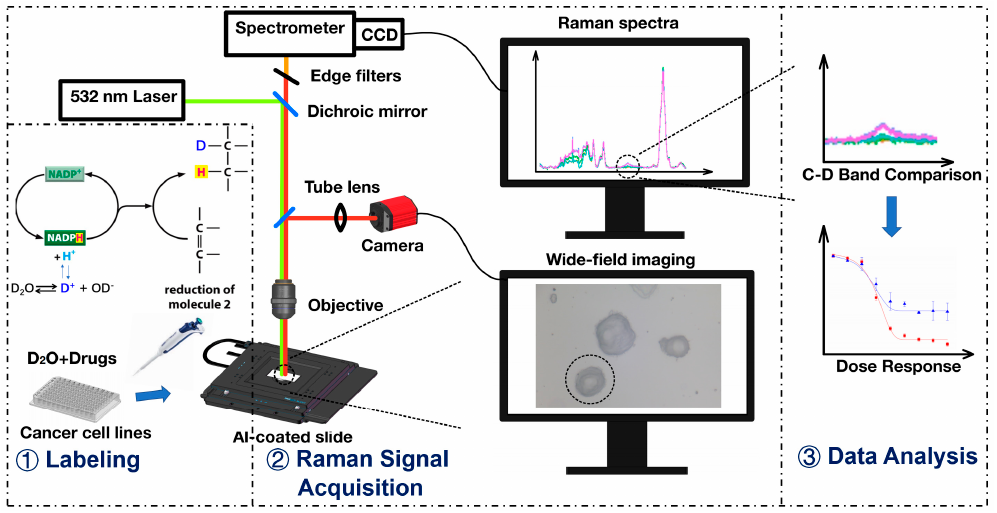
Figure 1. Schematic of the home-built Raman microscopy system and the experiment steps.